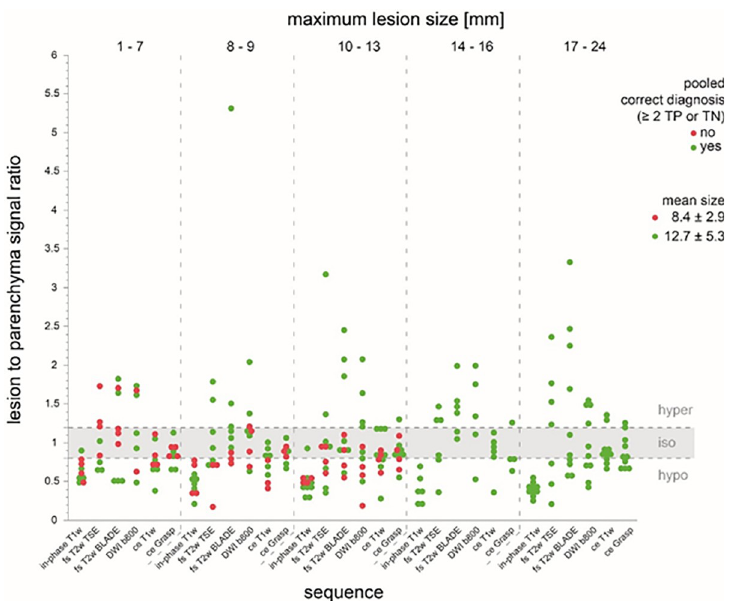
Fig 3. Relationship of PICT size to correct diagnosis. Correct diagnosis is indicated as green dot, wrong diagnosis as red dot. If the size is below 13mm signal characteristics are more important for the correct diagnosis. In PICTs below 13mm, fewer correct diagnoses were made in the isotime corridor. T2w Haste coronal and axial as well as coronal ce T1w Dixon VIBE sequence are not depicted in this figure. https://doi.org/10.1371/journal.pone.0253078.g003 Depending on the sequence, a considerable proportion of lesions were isointense with regard to the T2B ratio ranging from 29% (DWI b-800 s/mm 2 ) to 68% (ce GRASP, Fig 2). For all PICTs, the sequences with the most conspicuous mean T2B ratios were unenhanced in- phase T1w (0.74 ± 0.17, hypointense), fs T2 BLADE (1.59 ± 0.87; hyperintense) followed by DWI (b-value 50 s/mm 2 ; 1.42 ± 0.70; hyperintense). The mean T2B ratio on in-phase T1w was significantly closer to the poorly conspicuous isointense corridor (0.8–1.2) for undetected PICTs with 0.82 ± 0.14 compared to detected PICTs with 0.71 ± 0.17 (p-value 0.03). Although mean T2B ratios for T2w and DWI sequences were distinctly higher for detected versus unde- tected PICTs (Table 4), the difference was not significant. PICTs with a T2B ratio in the poorly conspicuous corridor (0.8–1.2; isointense) on any sequence were harder to detect when they